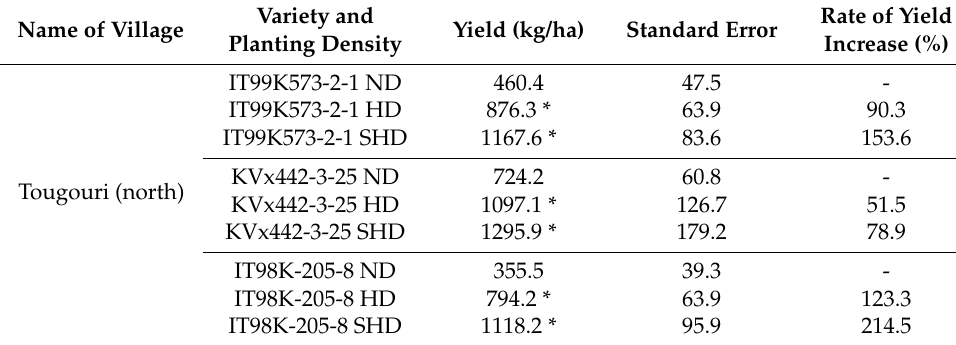
Table 3. Effect of high-, super high-density planting for the